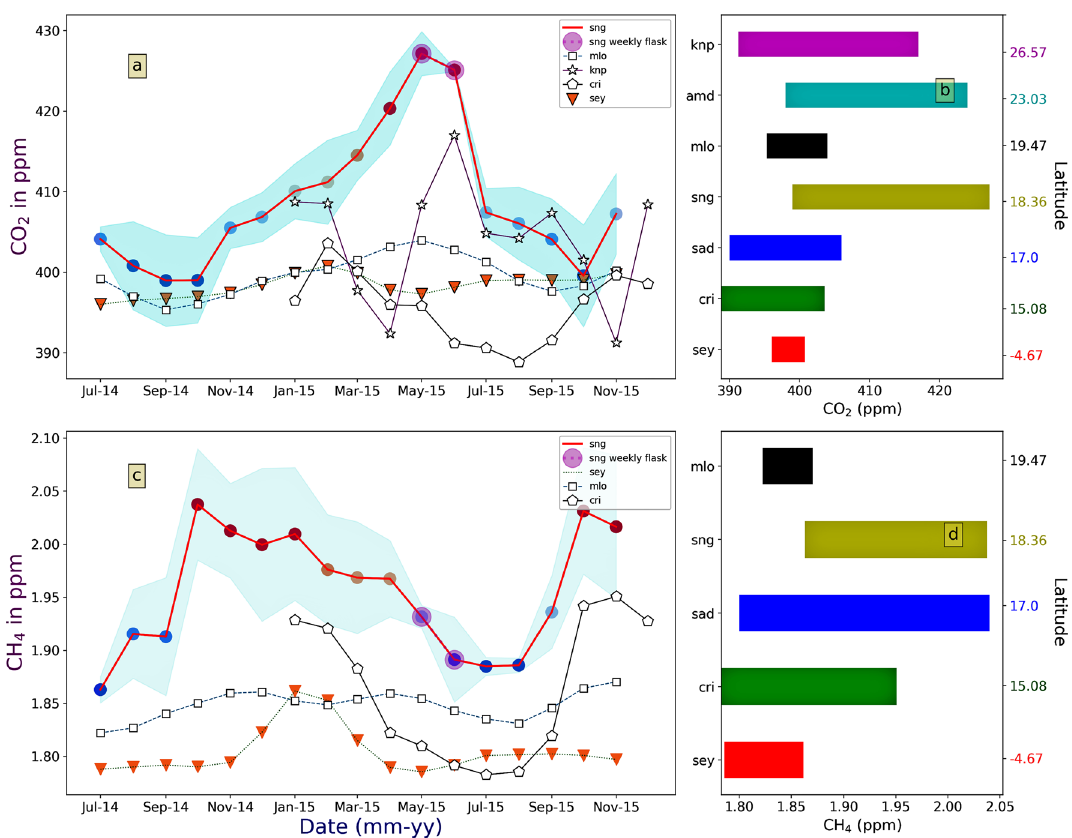
Figure 2. Seasonal variation of ( a ) CO 2 and ( c ) CH 4 at Sinhagad, for the year 2014–2015. The shaded region shows the standard deviation. Seasonal variations of other sites are also shown in the figure. N.B-Seasonal variation of knp is obtained in the year 2016, but it is shown in 2015 in the graph for comparison purpose only. Similarly, cri seasonality 33 is obtained from monthly mean data of 2010–2012 but shown in 2015 in the graph for comparison only. Highlighted markers in sng time series in May and June, 2015 is obtained from weekly flask samples to fill the gap. Seasonal amplitude (maximum − minimum) of several sites is shown in ( b ) for CO 2 and in ( d ) for CH 4